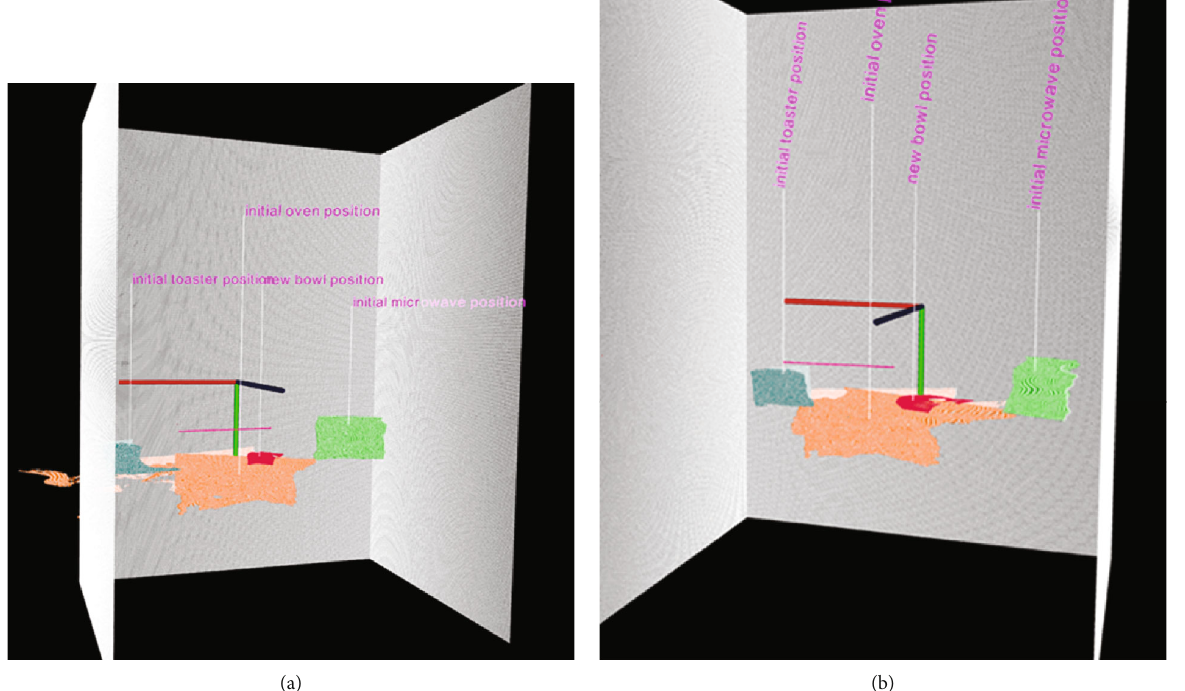
Figure 12: Similar to Figure 8, this fi gure shows two views of the calibrated virtual scene of the kitchen based on the merged point clouds of the two depth sensors. Both views show the segmented portion of the point clouds associated with the detected objects after the older adult has left the monitoring area. Virtual reconstruction size of the point cloud is based on the physical sizes of the objects. The detected objects in the RGB image are used to segment the associated point cloud for determining their approximate position with respect to the real and virtual scenes. For example, the orange points represent point clouds associated with the fi nal position of the oven. Although the movement trajectory information is not used in this paper, the fi gure shows also a sample movement trajectory of older adult in the monitoring